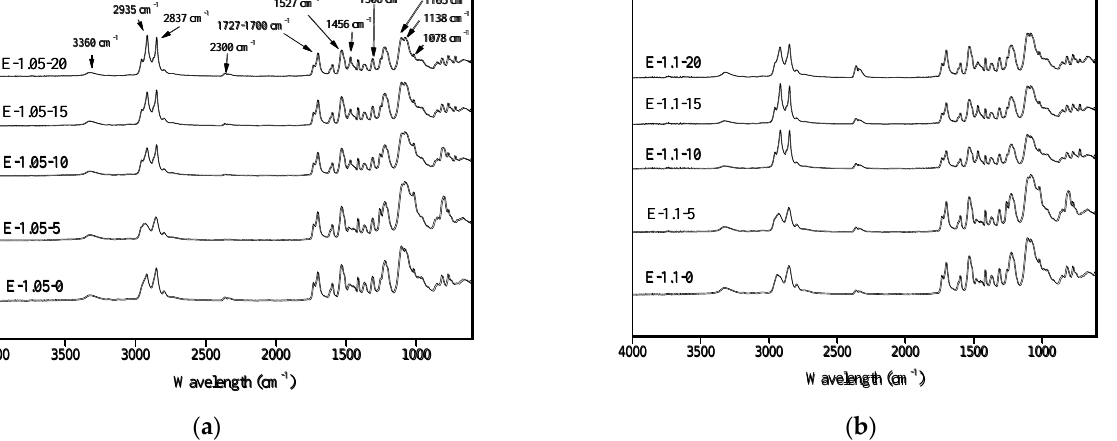
Figure 2. FT-IR spectrums of the synthesized elastomers with different mSD-(LDPE·EVA-RT27) contents and [NCO]/[OH] values of ( a ) 1.05 and ( b ) 1.1.